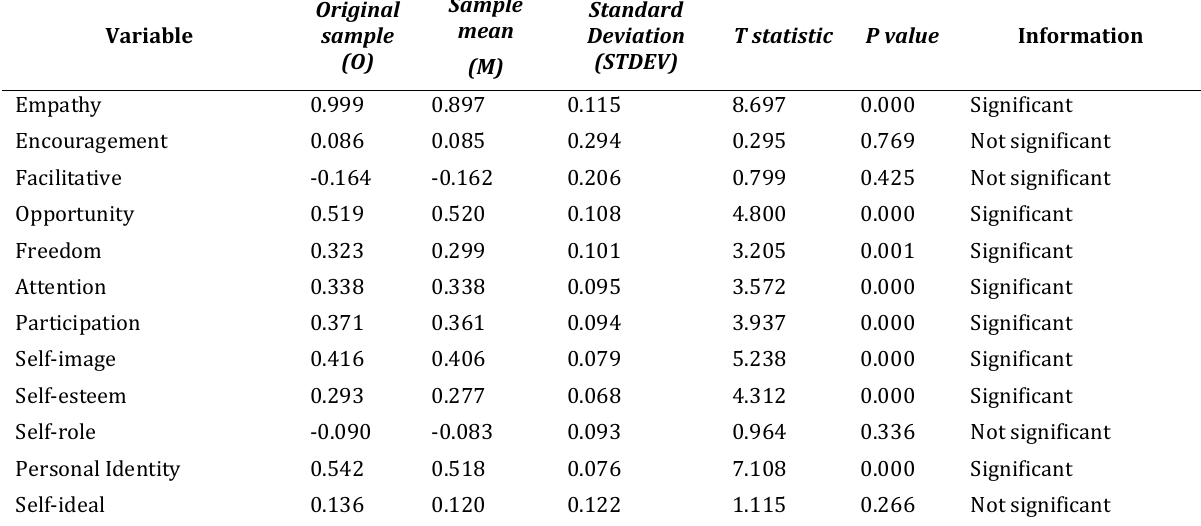
Table 5. Values of Outer Weights in Outer Model of Self-Concept of Leprosy Patients